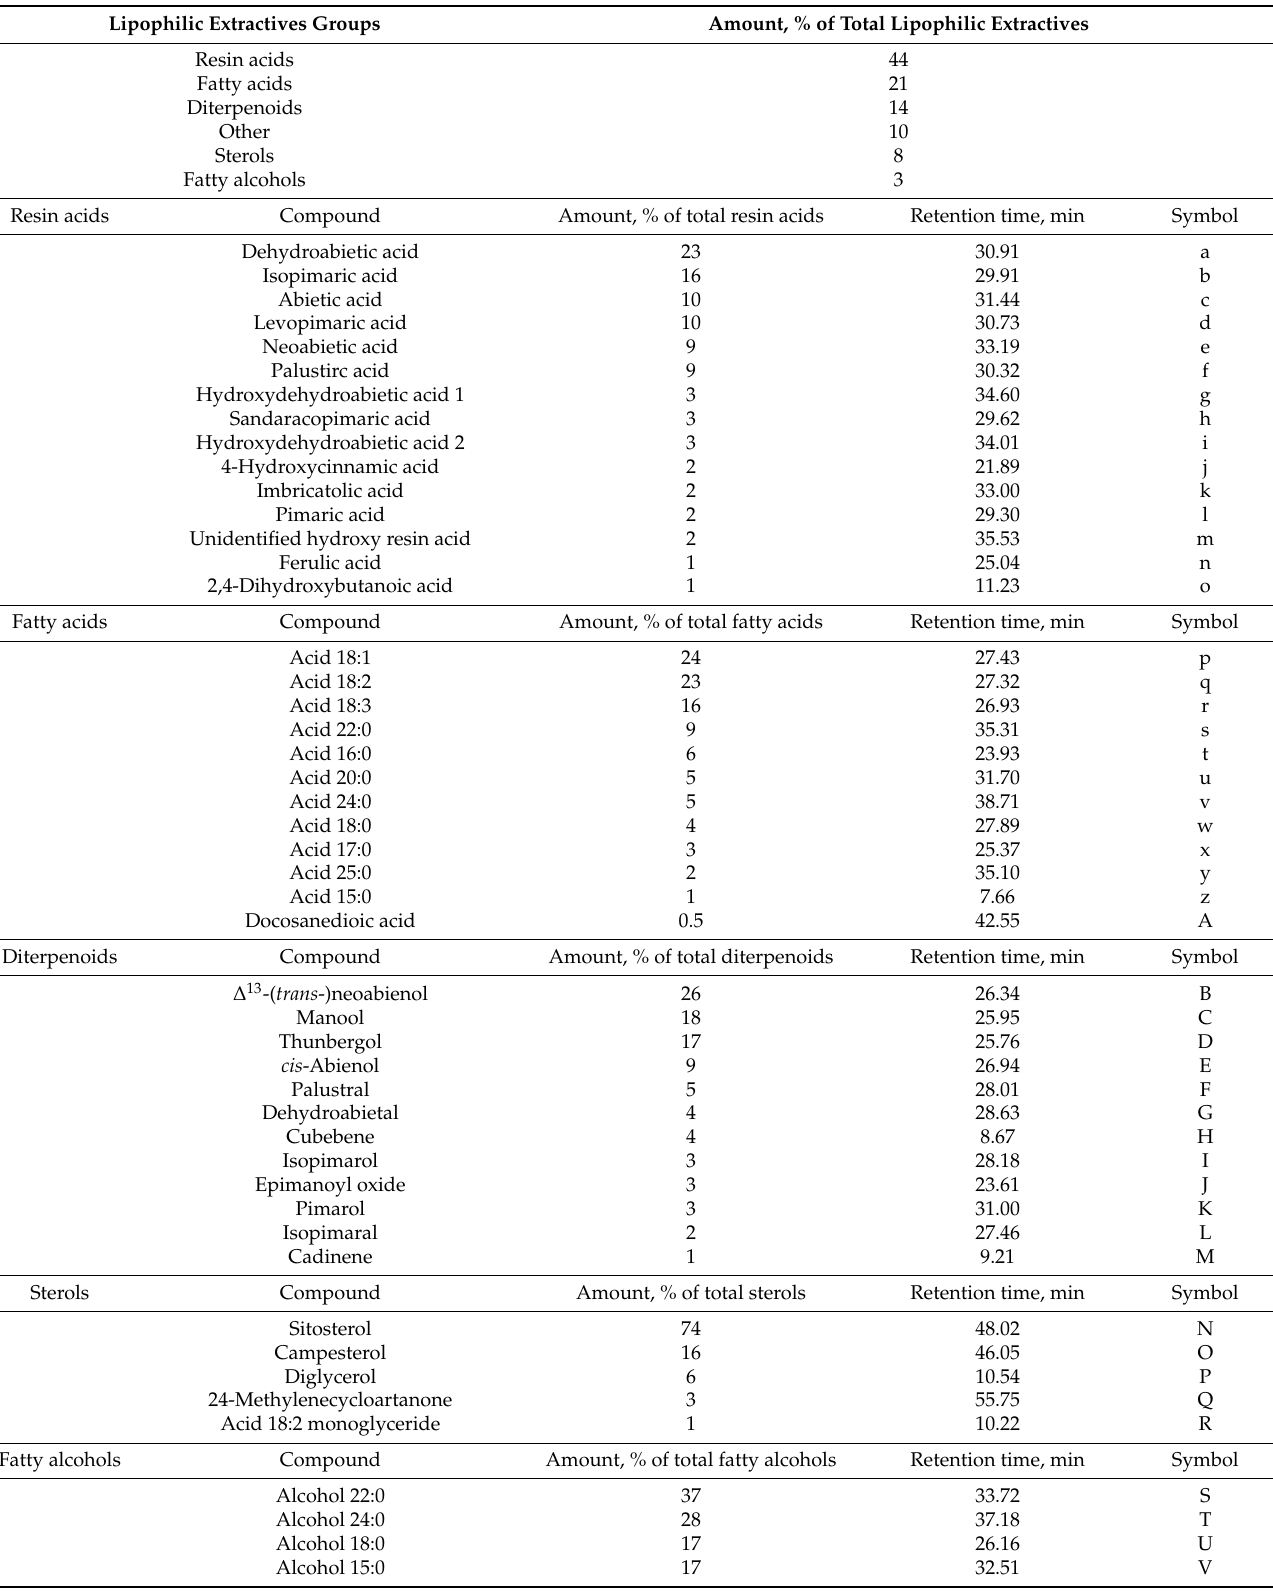
Table 3. Primary spruce bark lipophilic extractives identified and quantified by gas chromatography-mass spectrometry